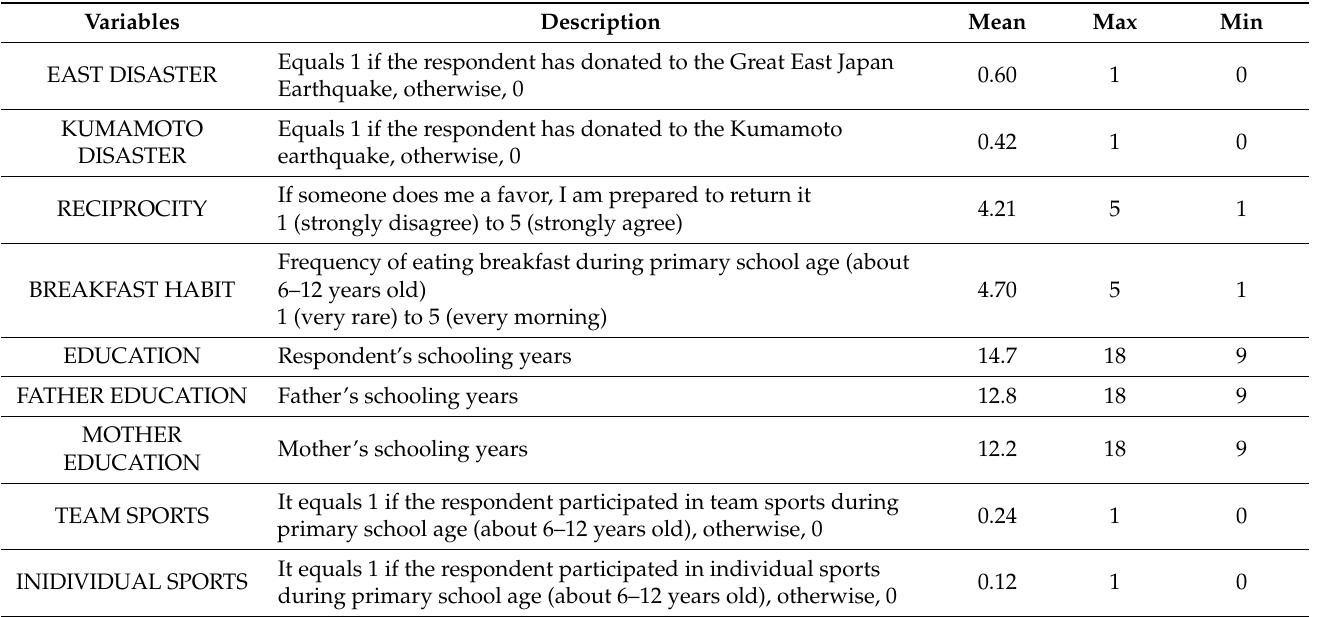
Table 1. Descriptions about variables and its